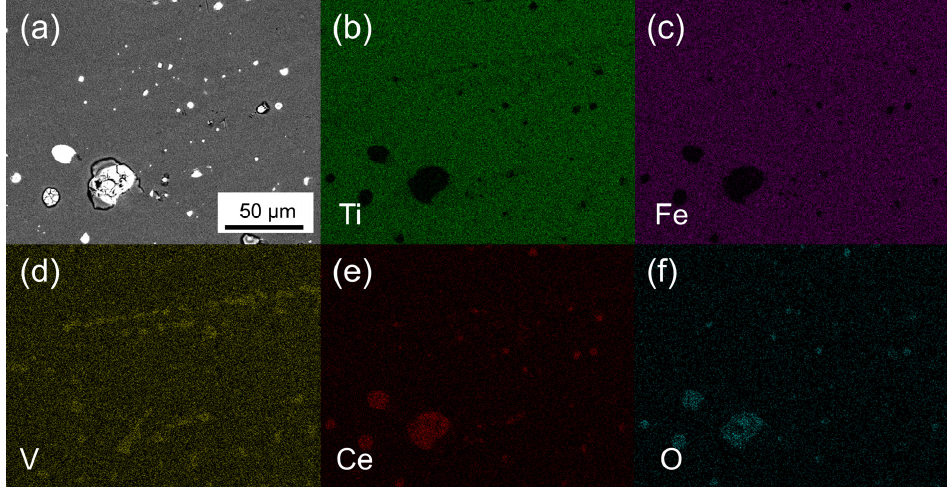
Figure 5. SEM BSE image and EDX elemental map of sample 8: ( a ) BSE image; ( b ) Ti; ( c ) Fe; ( d ) V; ( e ) Ce; ( f )